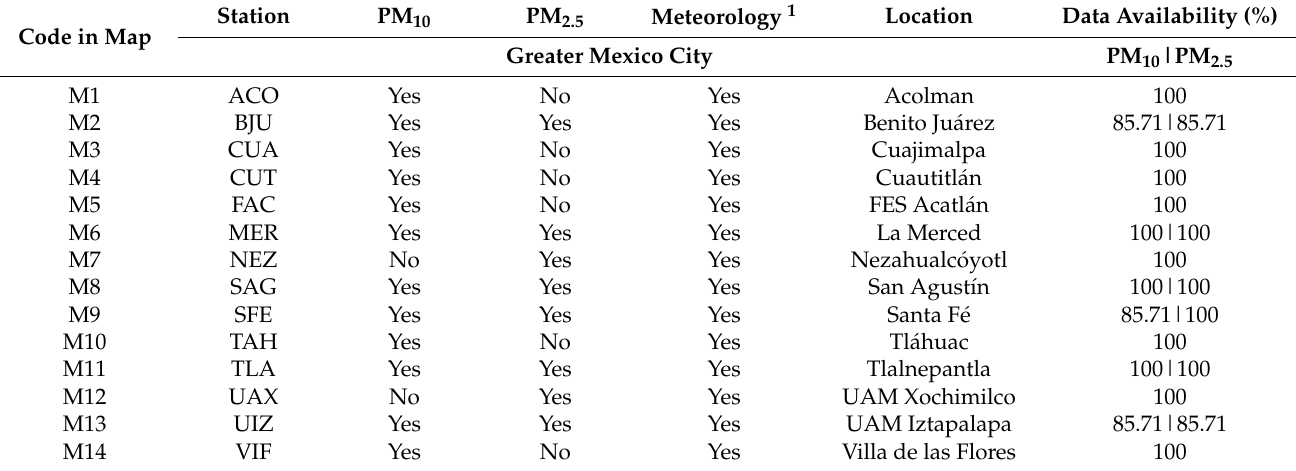
Table A1. Stations selected for this study in Mexico City, Guadalajara, and Monterrey. Code in Map